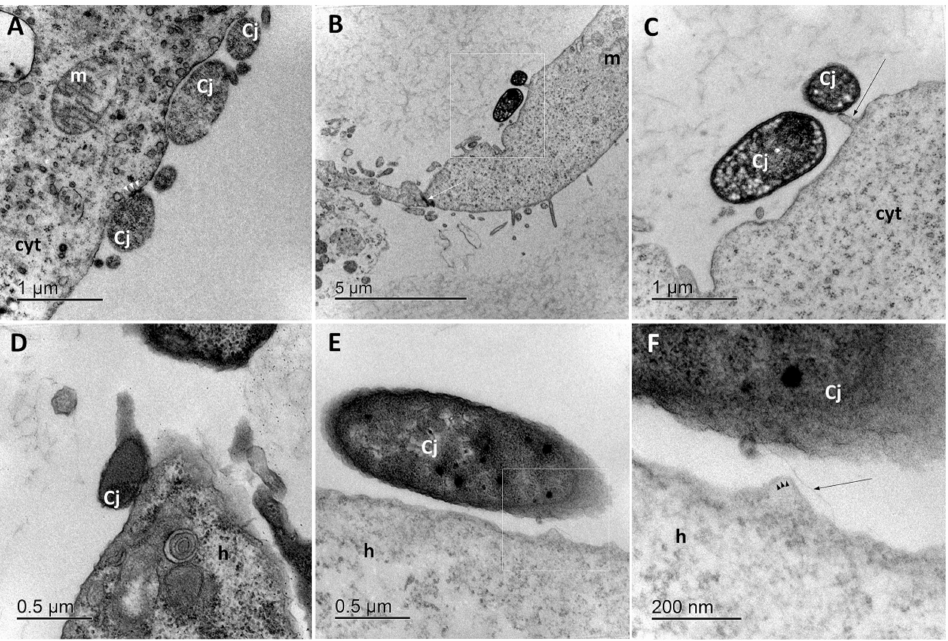
Figure 2. Representative transmission electron micrographs of C. jejuni cells adhered to biotic surfaces. ( A – C ) Adhesion to Caco-2 cells, with enlargement of the box in ( B ) shown in ( C ). ( D – F ) Adhesion to A. castellanii , with enlargement of the box in ( D ) shown in ( F ). Cj, Campylobacter jejuni ; m, mitochondrion; cyt, cytoplasm of Caco-2 cell; h, hyaloplasm of A. castellanii . Scale bars, as